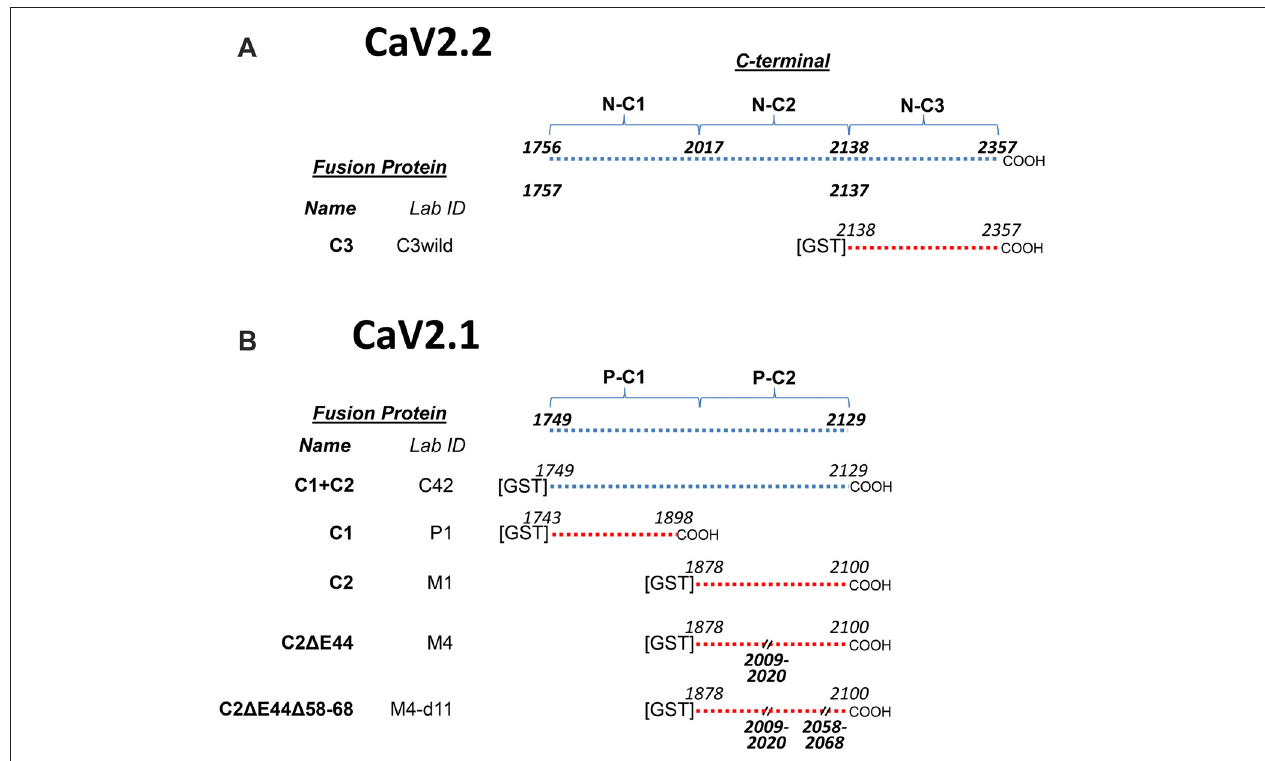
FIGURE 1 | Constructs used in this project. (A) CaV2.2C-terminal constructs. The top line shows the full-length C-terminal and its operation division into three regions, C1, C2 and C3 together with the corresponding beginning and end amino acid sequence (aa) numbers. The CaV2.2 C3 region fusion protein, used as a control in this study, is detailed at the bottom with aa numbers. (B) CaV2.1C-terminal constructs. The full-length C-terminal diagram at the top lacks the distal third when compared to CaV2.2 (A) and is operationally divided into C1 and C2 regions to permit direct comparison to the CaV2.2 C-terminal (see text). Fusion proteins are listed below with the beginning and end aa numbers and aa deletions. Each fusion protein has two names, one unique identifier (Lab ID) and in bold text a functional name, as used in the text, reflecting its C-terminal third (C1, C2, C3 plus deletion